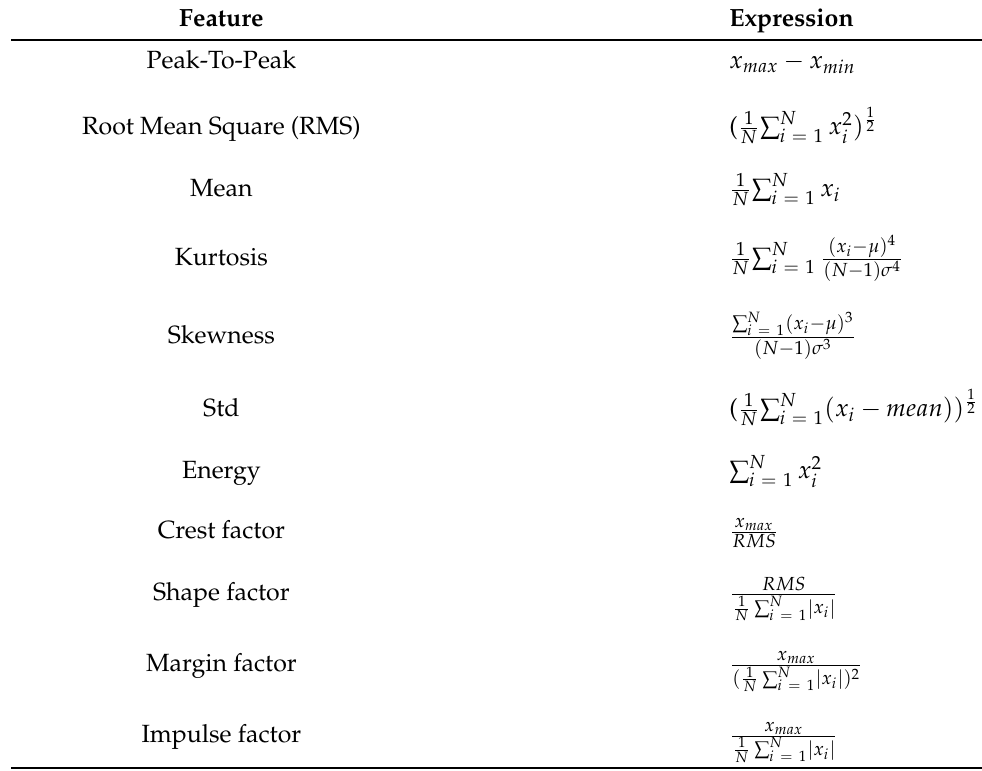
Table 1. Time-domain